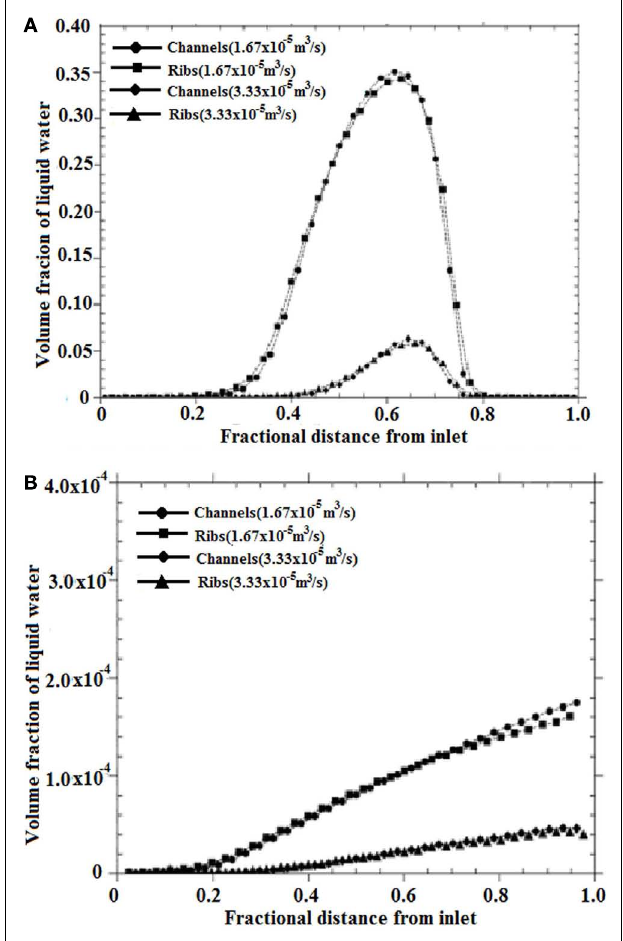
FIGURE 7 |Water distribution inside the cell channel (Jithesh et al., 2012) . (A) Parallel flow field and (B) serpentine flow field.